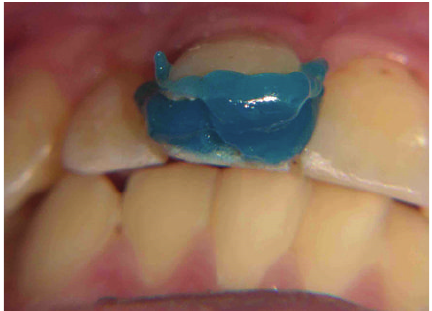
Figure 2: Initial periapical radiograph.